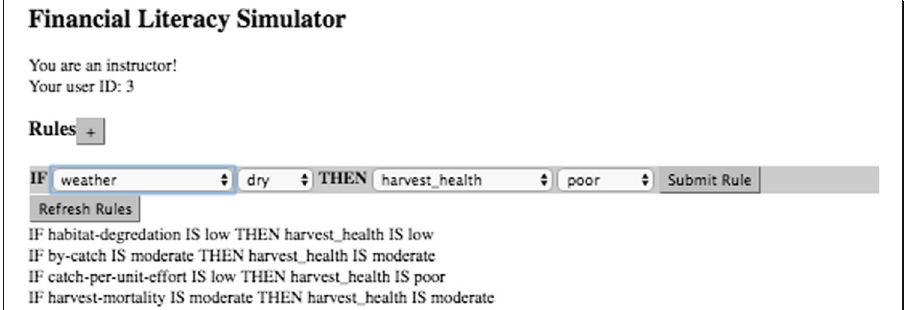
Fig. 3 Fuzzy logic aggregation